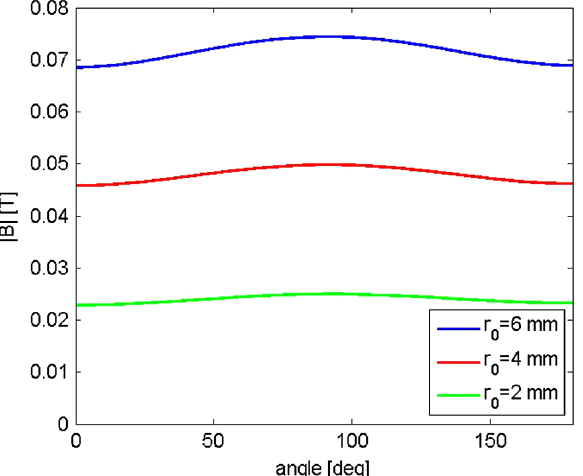
mm.FIG. 17. Azimuthal magnetic field in the center of the full cell (referred to the case of a 120 MV = m accelerating field on the cathode) for three different circle